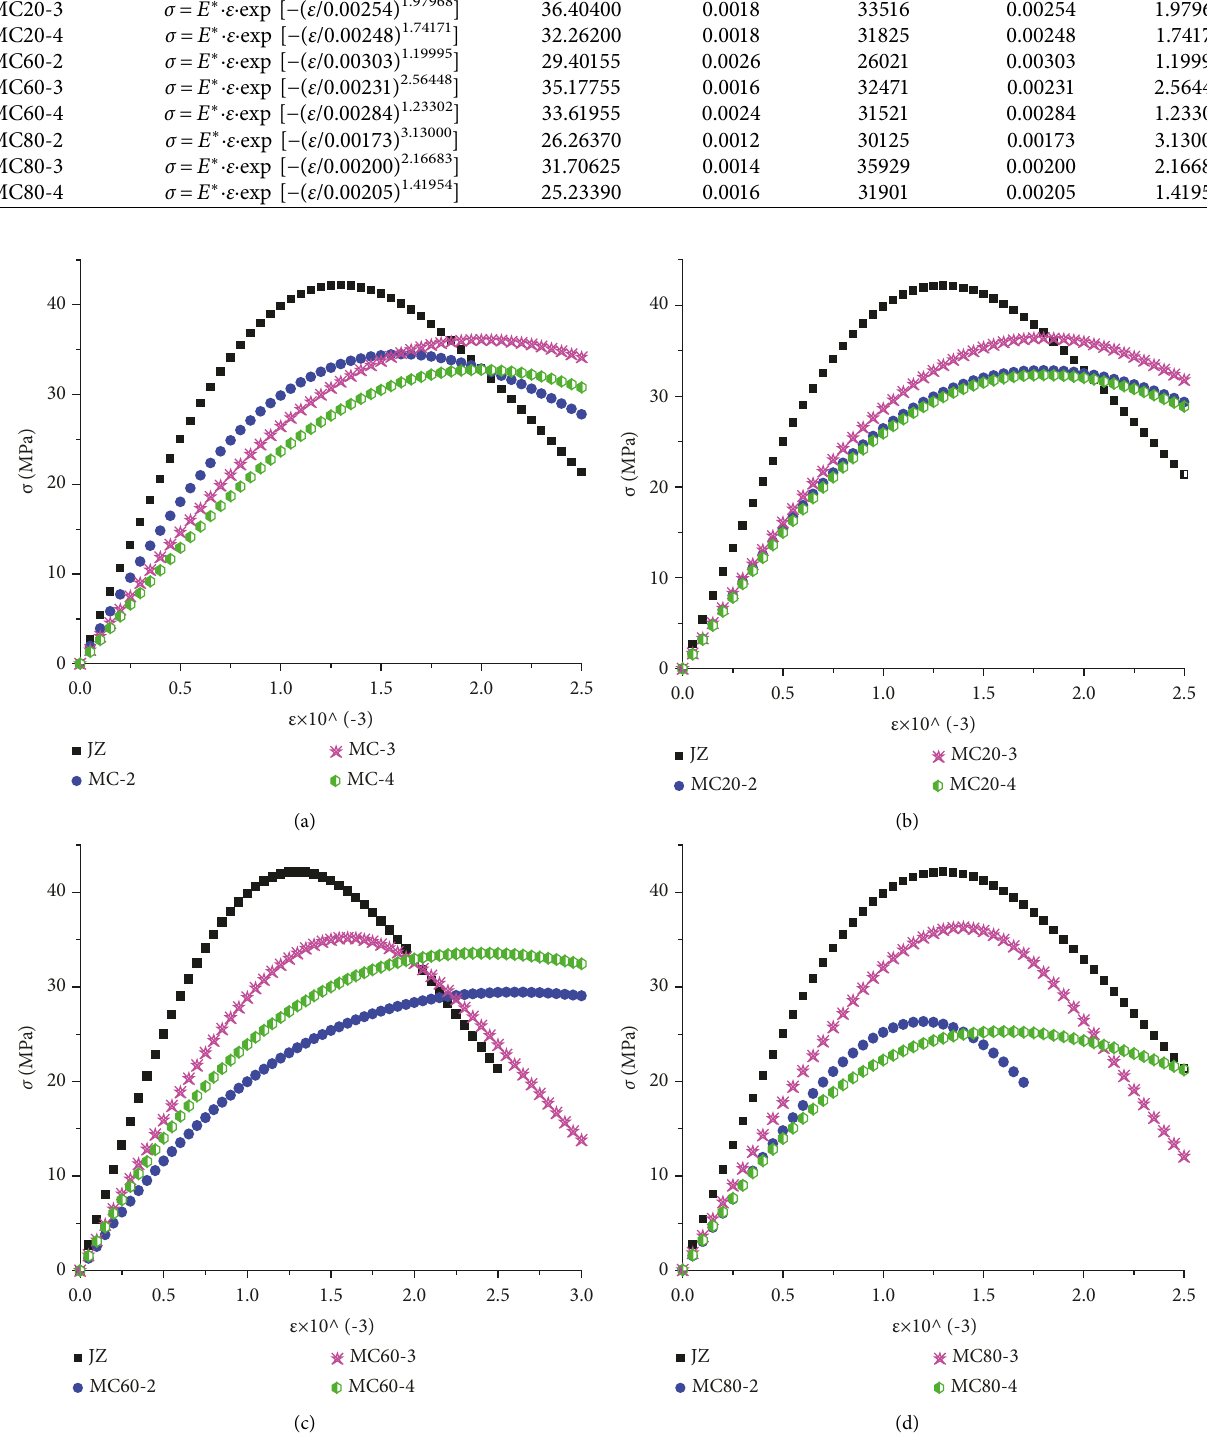
Figure 7: Stress-strain curve relationships under ideal stiffness. (a) Stress-strain curve relationship of MC group. (b) Stress-strain curve relationship of MC20 group. (c) Stress-strain curve relationship of MC60 group. (d) Stress-strain curve relationship of MC80